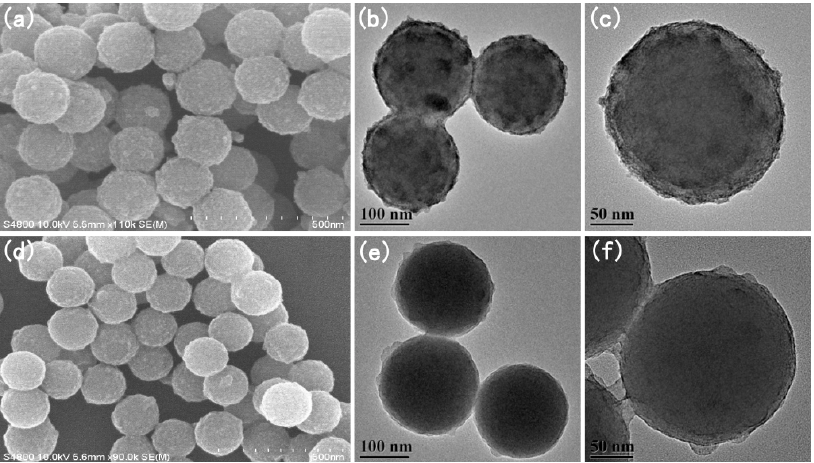
Figure 1. Scanning electron microscope (SEM) and Transmission electron microscope (TEM) images of SiO 2 ( a , b ) and SiO 2 @PMDA-Si ( d , e ). Histograms of nanoparticle size distribution of SiO 2 ( c ) and Figure 2. SEM images of SiO 2 @PMDA-Si-Tb ( a ) and SiO 2 @PMDA-Si-Tb-phen ( d ); TEM images of SiO 2 @PMDA-Si ( f ). SiO 2 @PMDA-Si-Tb ( b , c ) and SiO 2 @PMDA-Si-Tb-phen ( e , f ).